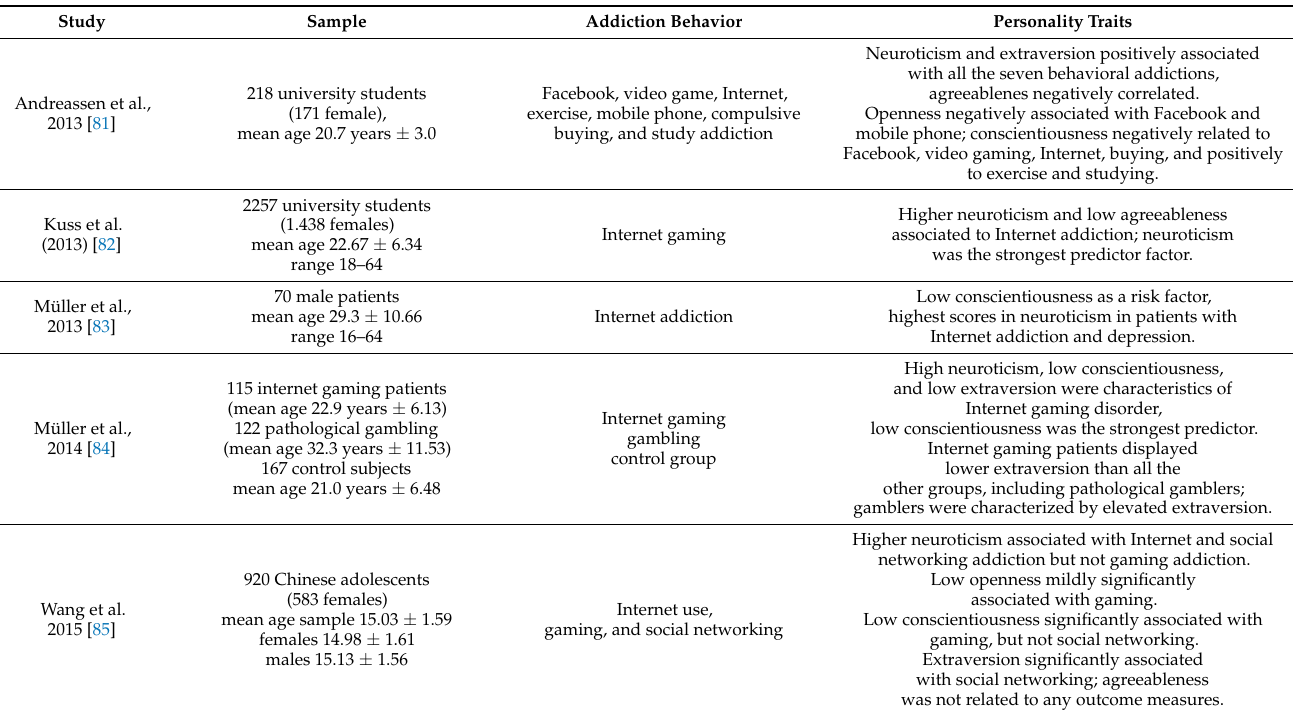
Table 2. Personality traits and individual behavioral